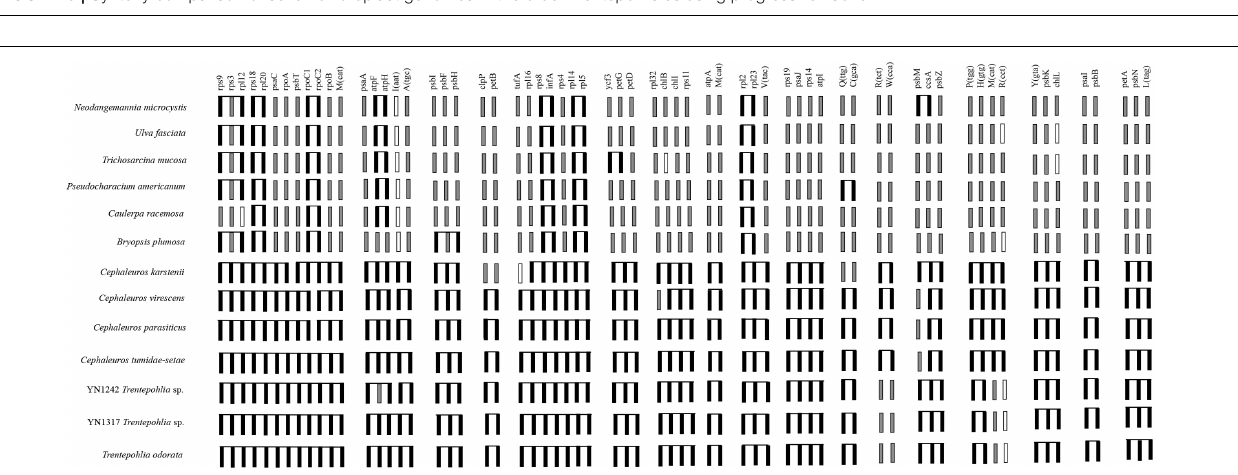
FIGURE 5 | Synteny comparison of seven chloroplast genomes in the order Trentepohliales using progressiveMauve.